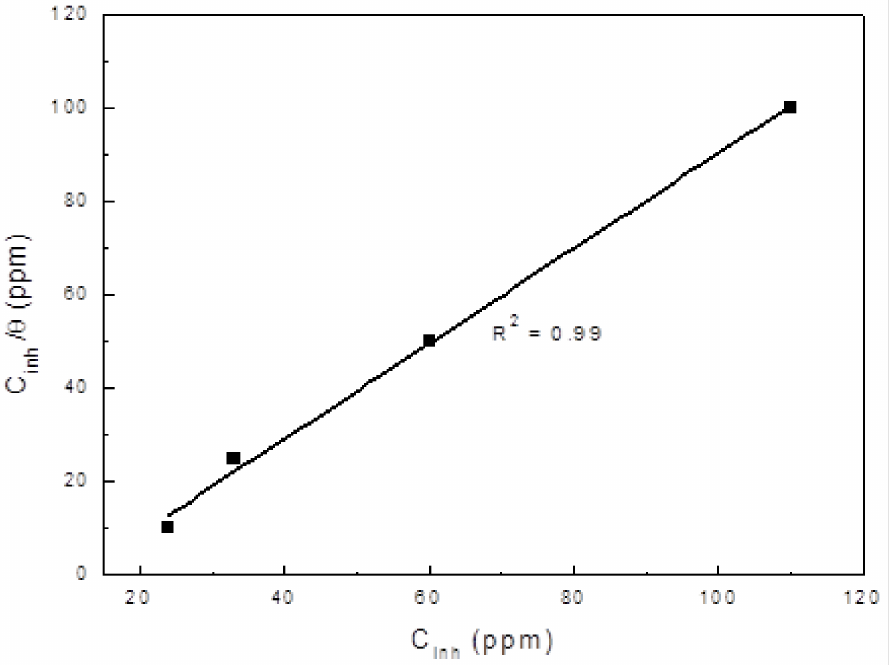
Figure 5. Langmuir adsorption isotherm for X-120 steel in a CO 2 -saturated NaCl solution containing different concentrations of gemini